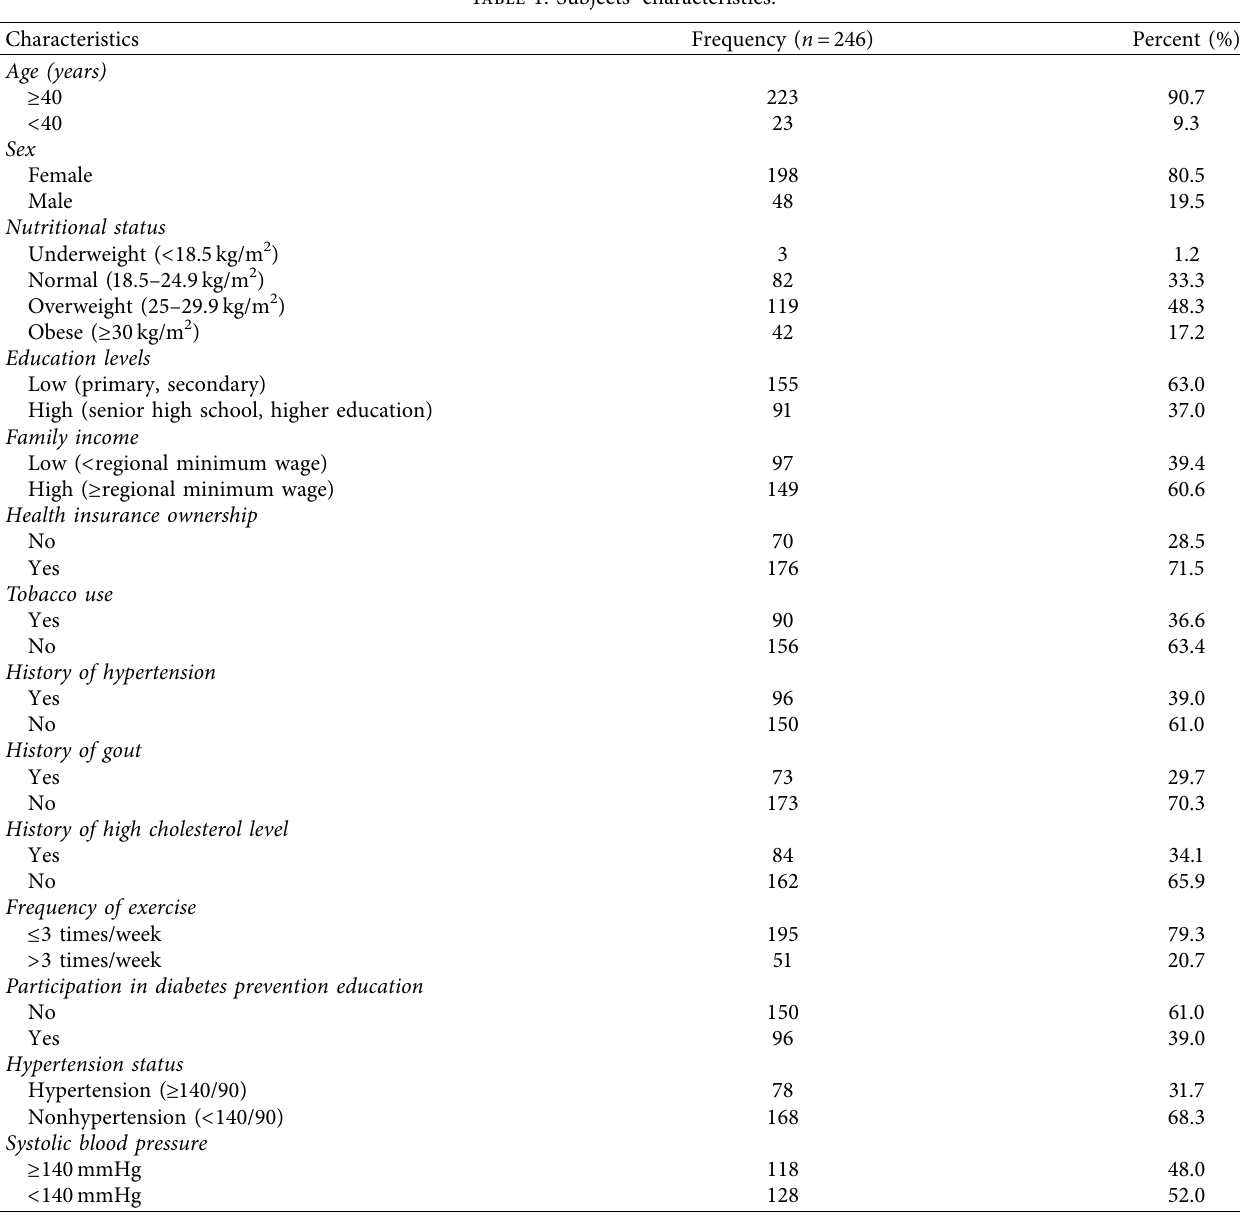
Figure 1: Flow diagram of subjects’ recruitment. Table 1: Subjects’